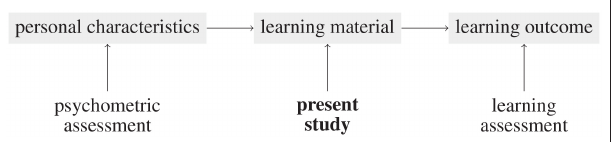
FIGURE 1 | Pinning down the quantitative assessment of learning media in a larger domain of learning